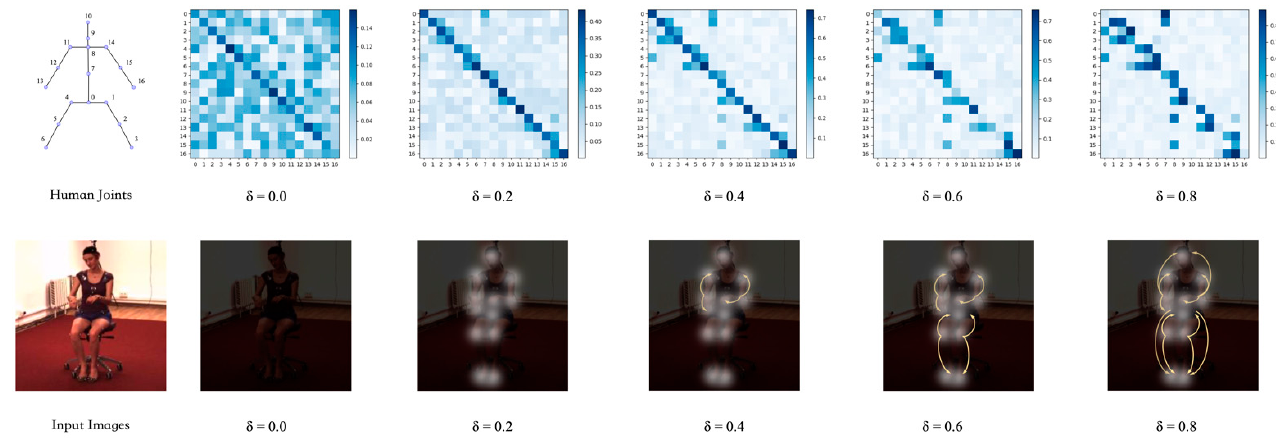
Figure 3. Results of joint relationship over human joints with the different values of δ . The first lines are confusion maps with the change of δ . Human joints show the index of joints. The confusion map represents the feature gain of the corresponding joint with other joints, and it indicates the constraints and similarities between joints. The second lines are manual connections with joints based on confusion maps. Table 3. Comparison of mean per joint position error (mm) in Human3.6M between the estimated pose and the ground truth. Lower values are better, with the best in bold, and the second best un- derlined. ( a )Protocol#1: reconstruction error (MPJPE).